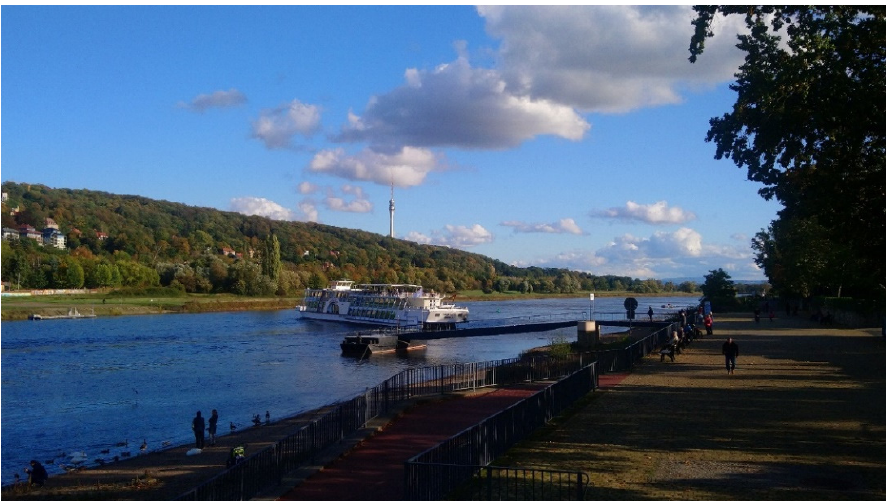
Figure 2. Dresden, view across the River Elbe to the survey location Loschwitz Elbe meadows (photo: R.-U. Syrbe).